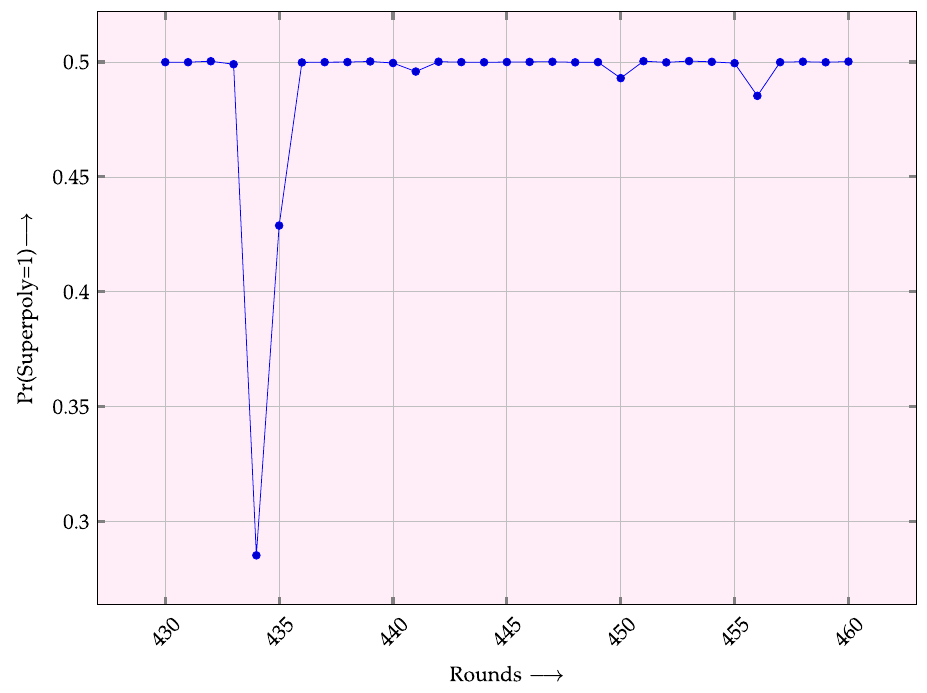
Figure 2. Probability of superpoly being 1 for different rounds for the cube { 69, 70, 76, 81, 86, 91, 92 } .